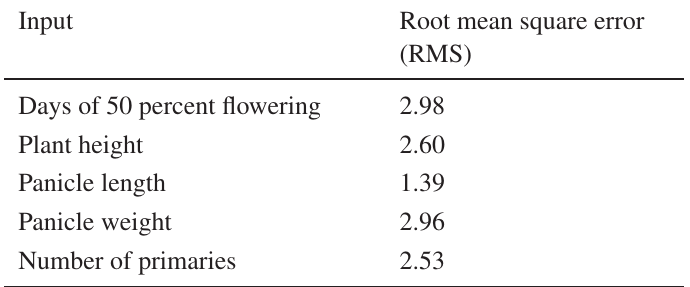
Table 1. Prediction results of one-to-one mappings.